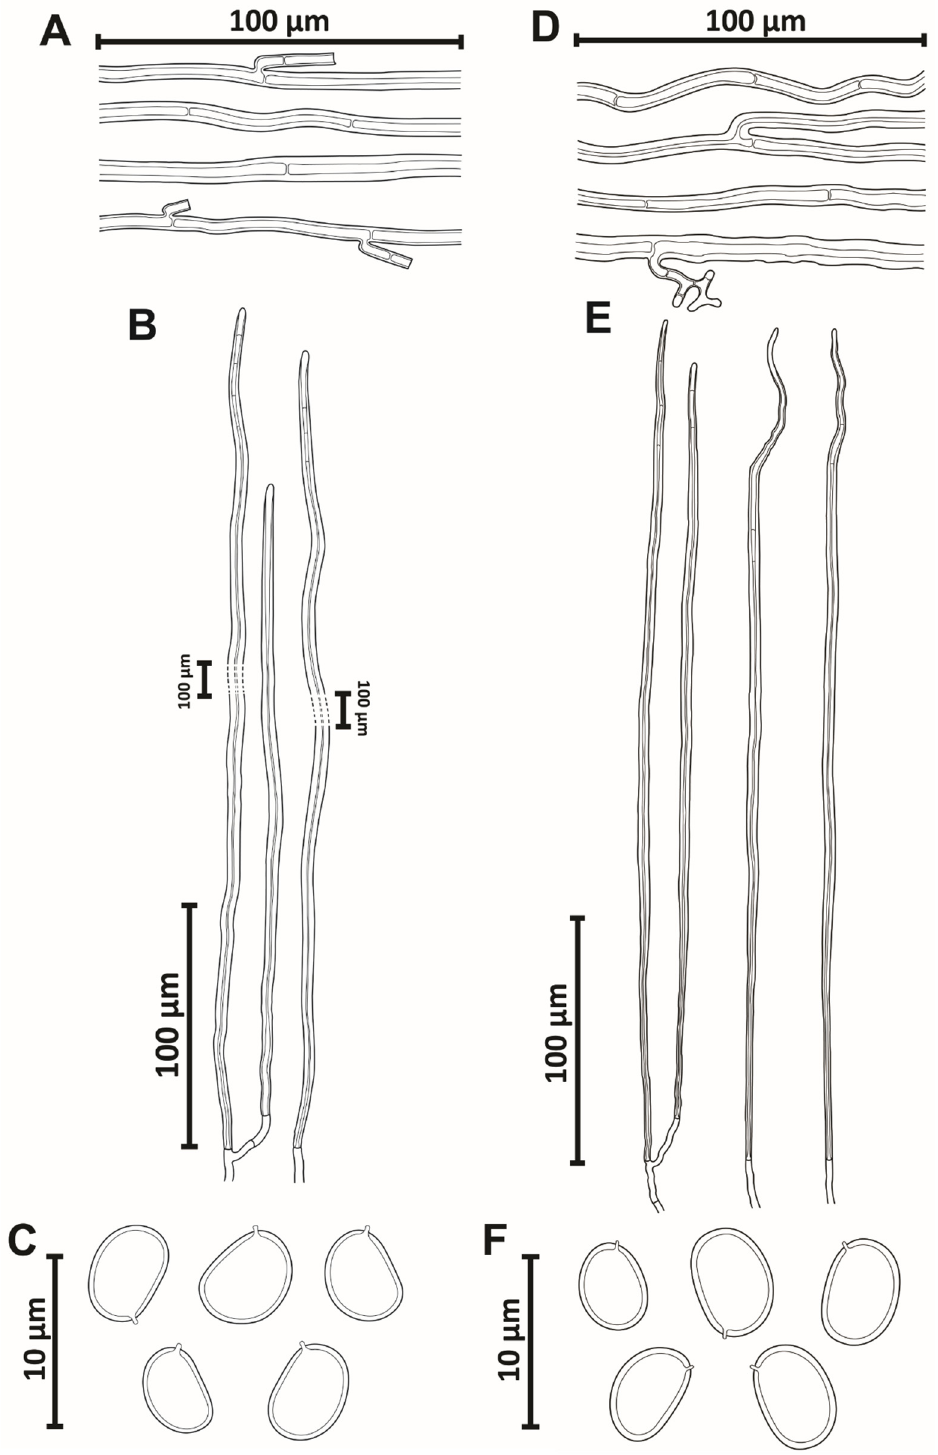
Figure 7. Micromorphological features of Phellinotus piptadeniae and P . teixierae . ( A – C ) Phellinotus piptadeniae . ( A ) generative hyphae of the context; ( B ) skeletal hyphae of the tubes; ( C ) basidiospores. ( D – F ) Phellinotus teixeirae . ( D ) Generative hyphae of the context; ( E ) skeletal hyphae of the tubes; ( F ) basidiospores.